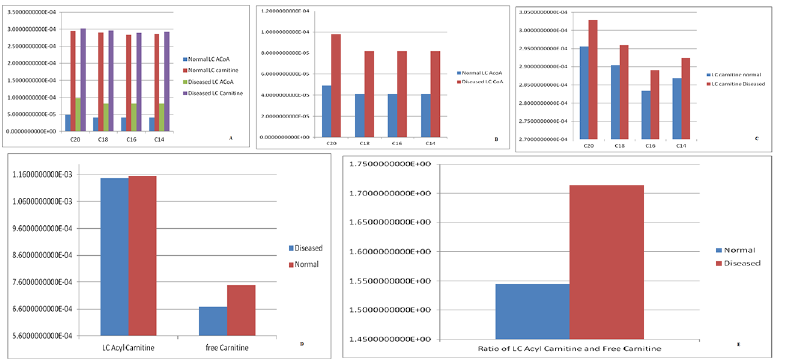
Fig 10. Simulated concentration of alpha-ketoglutarate (AKG) as a function of time. (a) Simulated concentration of alpha ketoglutarate as a function of time, increases initially as it is a substrate in rate limiting step of TCA. (b) Complete graph showing time course simulation of model for AKG.